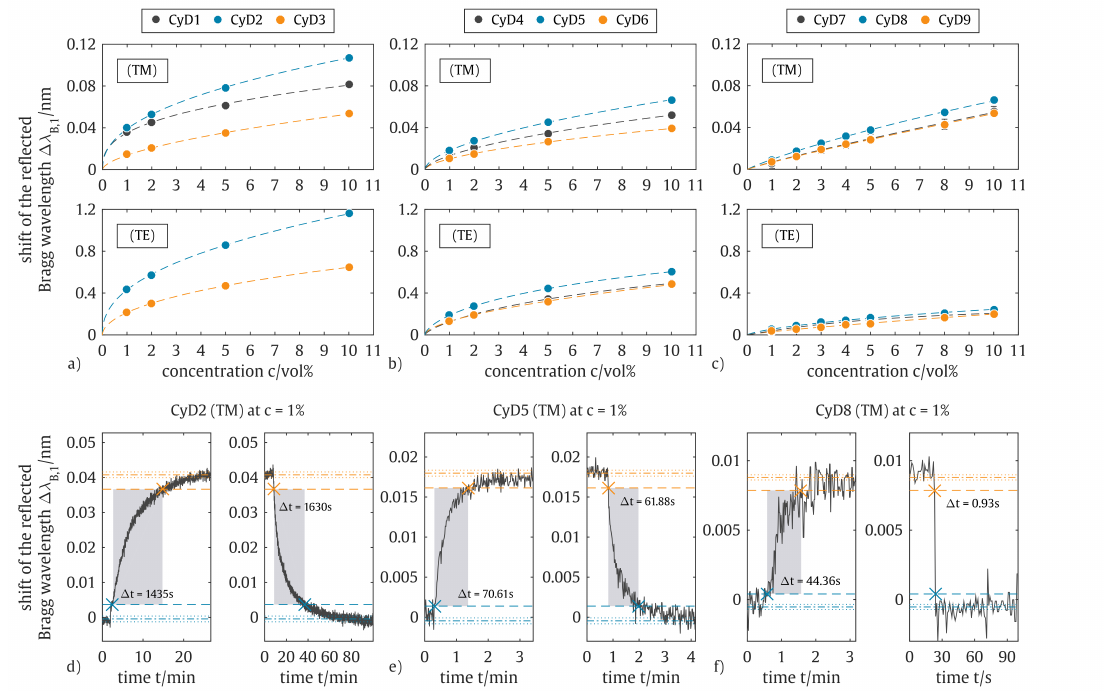
Figure 7. Sensor signal equilibria of the sensitized PBG-sensor depending on the applied CFC-11 concentration comprising Langmuir-Freundlich isotherm fits for the sensor coated with ( a ) per -methyl substituted CyD derivatives, ( b ) per -ethyl substituted CyD derivatives, and ( c ) per -allyl substituted CyD derivatives. Sensor signal’s temporal response to 1vol% CFC-11 exposure and pure nitrogen purge for the sensor coated with ( d ) a per -methyl substituted CyD derivative, ( e ) a per -ethyl substituted CyD derivative, and ( f ) a per -allyl substituted CyD